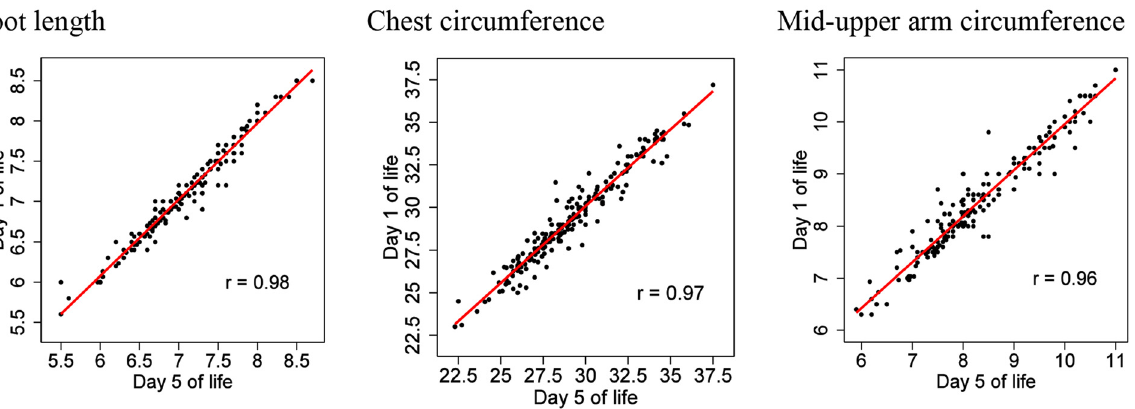
Fig 3. Scatter plots of anthropometric measurements taken at day 1 of life against measurements taken at day 5 of life (n = 200). The line of best fit and the correlation coefficient ( r) are also shown. All measurements are in centimetres.